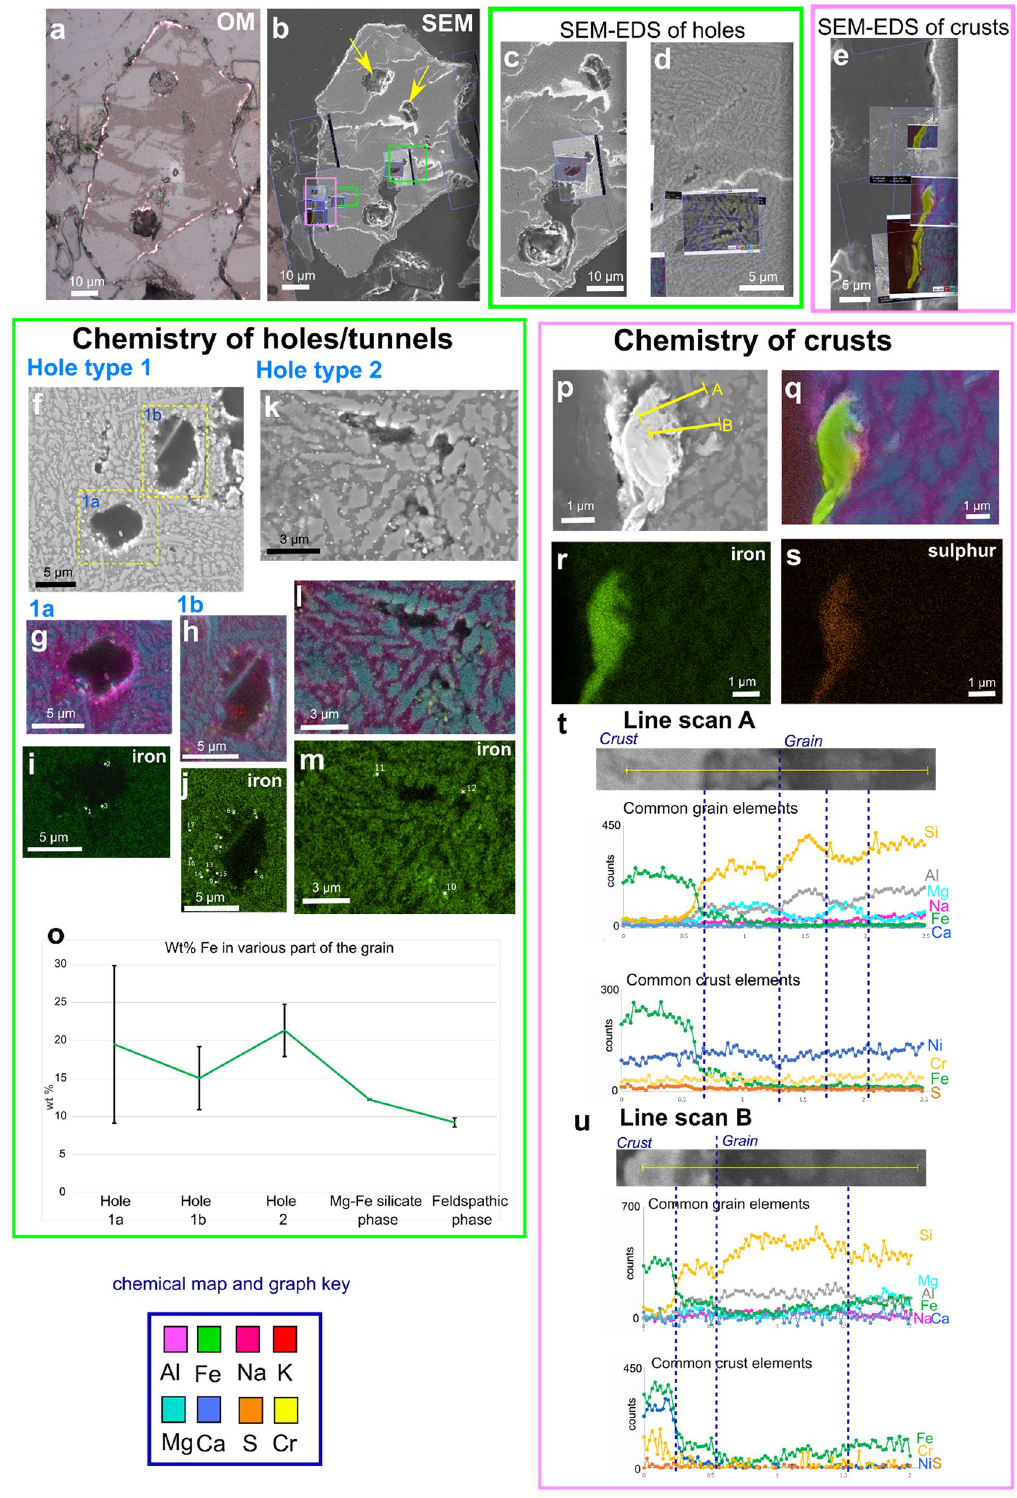
Figure 4. (a, b) Correlation of 2D imaging (OM, SEM) views of exposed grain of interest. (b) location of targeted areas of interest for SEM imaging and analysis via SEM–EDS. These were collected ‘live’ to enable correlation to specific areas (Supplementary Video S5). Yellow arrows indicate vesicular gas escape structures. Green box indicates holes of interest (c, d), while pink box represents grain surface crusts (e ). (f-m) SEM imaging and SEM–EDS maps of tunnel cross sections (holes) from exposed surface. Two types of hole are identified. Chemical and morphological variations in grain mineralogical phases also shown. (o) Wt% of Fe variations shown for different hole types and the different mineralogical phases; spot analyses locations shown in (i-m) . (p-s) SEM imaging and chemical SEM–EDS maps of grain surface crusts shown; chemical line scans in (p) shown in (t-u). Y axis in (t-u) is counts per second. The brighter grey mineralogical phase contains Mg, Ca and Fe (interpreted as a Mg-Fe silicate phase), and a darker grey mineralogical phase containing Al, Na, K, Si and O (interpreted as a feldspathic phase). SEM images collected using SESI